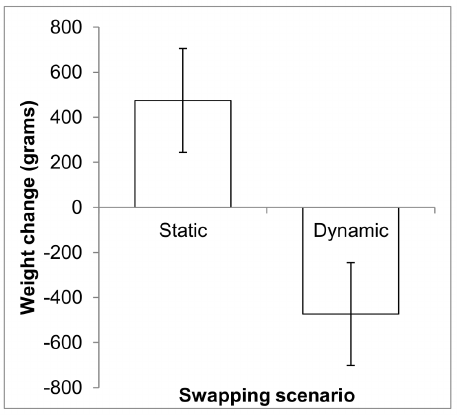
Figure 1. Raccoon weight change. Mean ( 6 1 SD) change in weight of virtual raccoons for simulations with static and temporally dynamic food maps. Weight change values are for animals that successfully established home ranges during the simulation (Base n=58; Swap n=54).